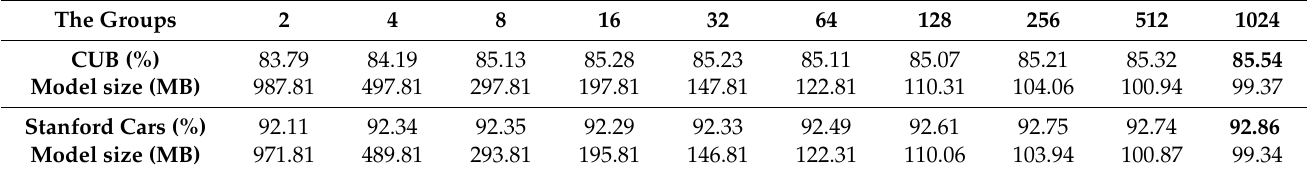
Figure 4. ( a ) The classification accuracy of Intra-GBP and Inter-GBP based on VGG-16 on Stanford Cars dataset; ( b ) The corresponding model size with different g (including backbone CNN); ( c ) The amount of calculation for pooling and classification. Table 2. The performances of Inter-GBP based on ResNet-50 on CUB dataset and Stanford Cars